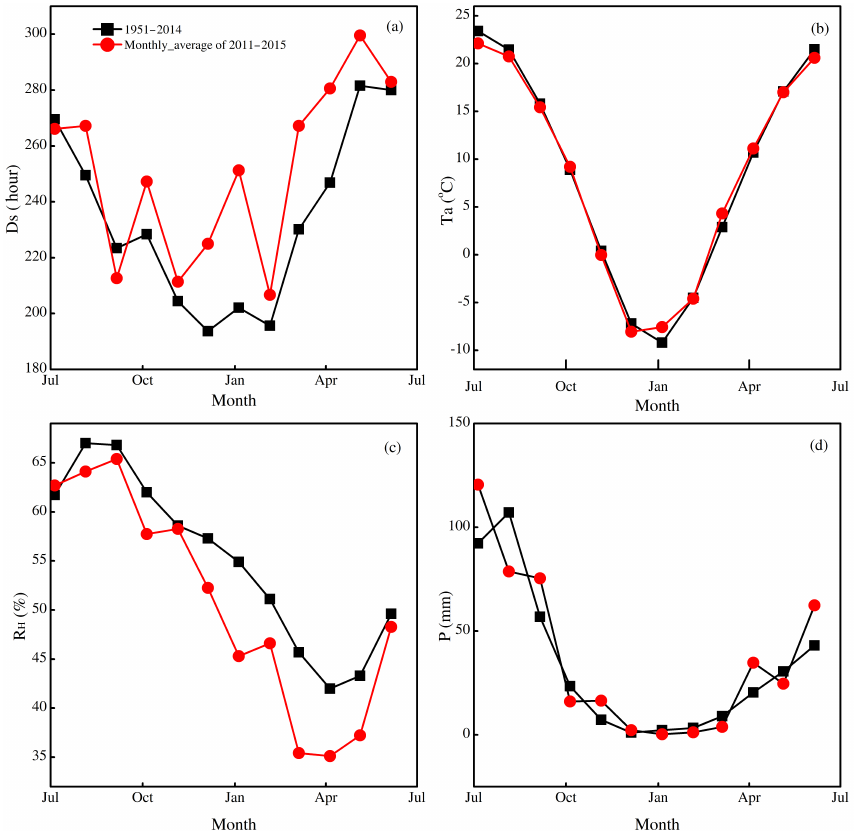
Figure 4. Seasonal characteristics of 4-year and long-term (1954–2014, from Yulin meteorological station) average monthly values of (a) sun- shine duration ( D S ) ; (b) air temperature ( T a ) ; (c) relative humidity ( R H ) ; and (d) total precipitation ( P